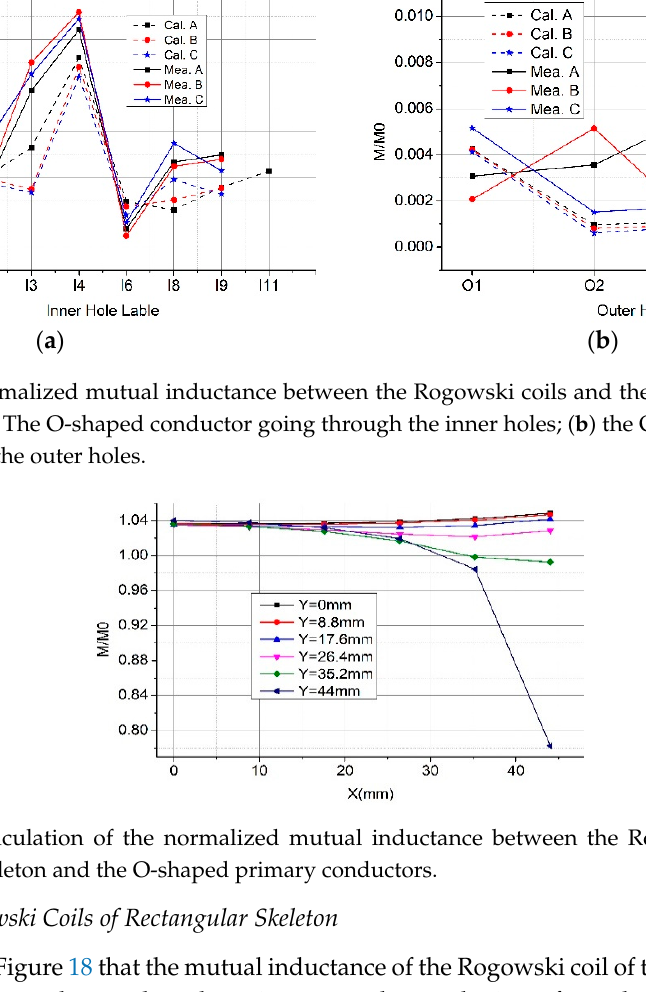
going through the outer holes.